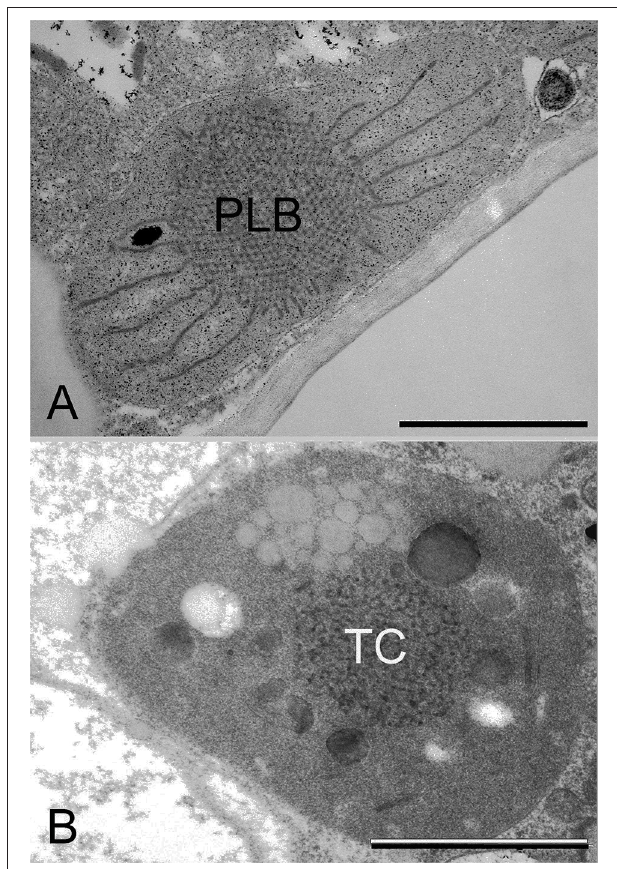
FIGURE 5 | Transmission electron micrographs of the prolamellar body (PLB) present in the etioplast of the cotyledon of a 2-week-old dark-germinated rosemary ( Rosmarinus officinalis ) seedling (A) , and tubular complex (TC) of a leucoplast of the neck cell of a peltate glandular hair on the surface of a light-grown adult rosemary plant (B) . Scale bar: 1 µ m. Sample preparation was as described in Böszörményi et al.